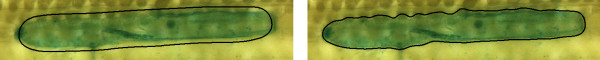
Cell segmentation via an active contour. The approximate cell boundary found by edge detection (left) is iteratively refined by moving the contour towards the true edge of the stained cell (right).